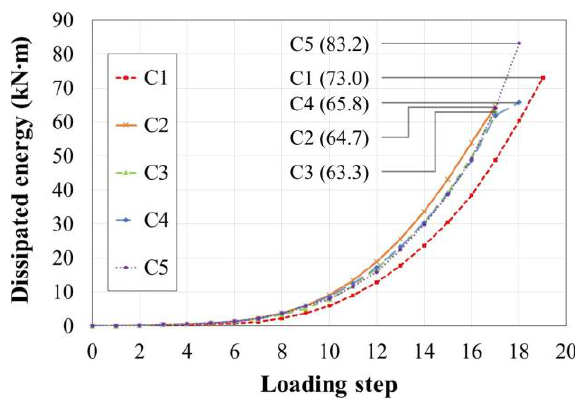
Figure 11. Cumulative dissipated energy until failure.